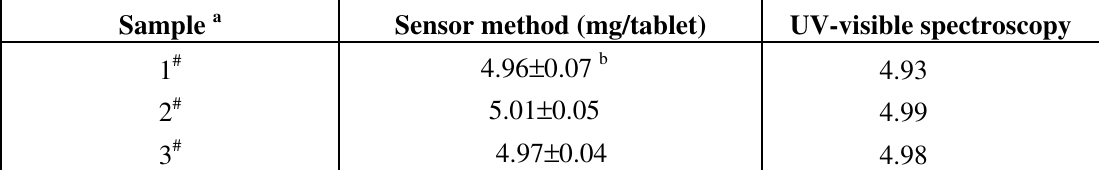
Table 3 MTZ determination with the MnT( o -glu)TTCl modified electrode in the pharmaceutical